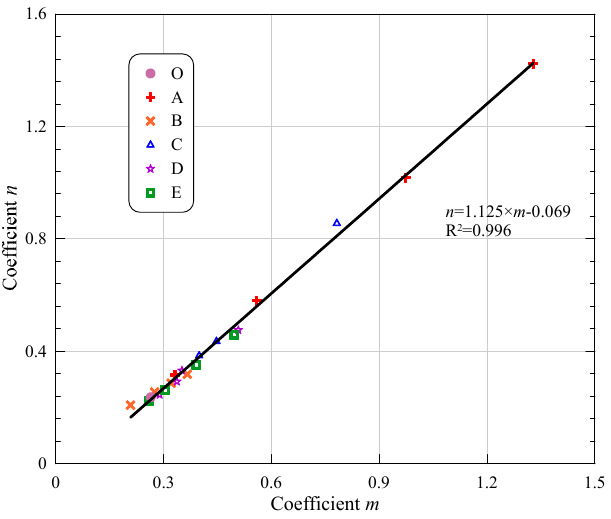
Figure 15. Relationship between coefficient m and n.